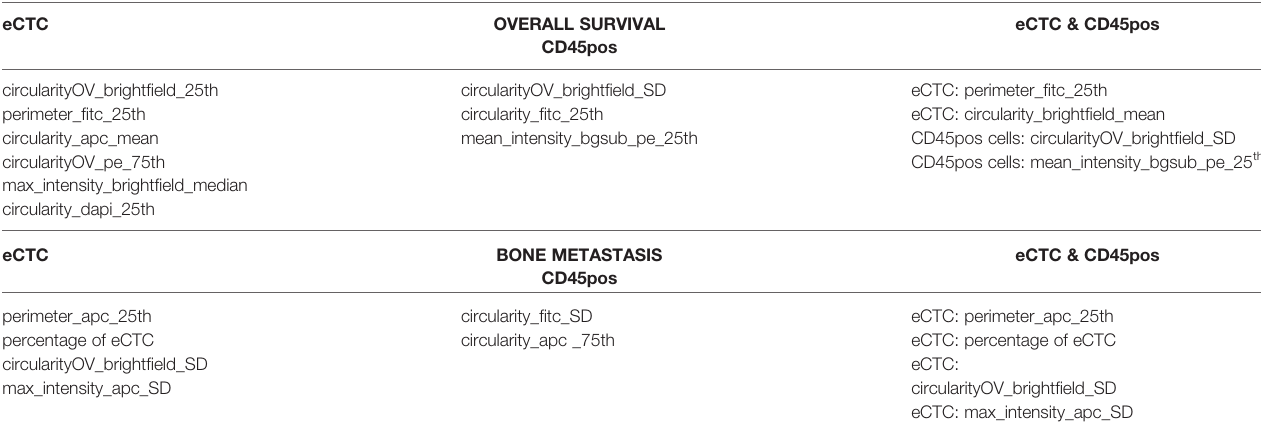
TABLE 5 | Features identi fi ed by the naïve Bayes approach as the most informative to predict overall survival and bone metastasis considering eCTC features alone (left), CD45pos alone (center) or both (right).